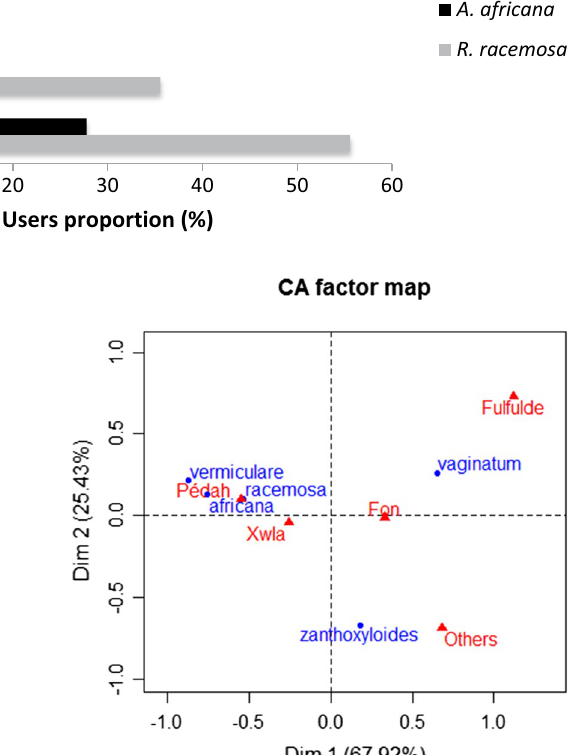
Fig. 3 Correspondence Factor Analysis results of use-values of mangrove species accord- ing to farmers’ ethnical